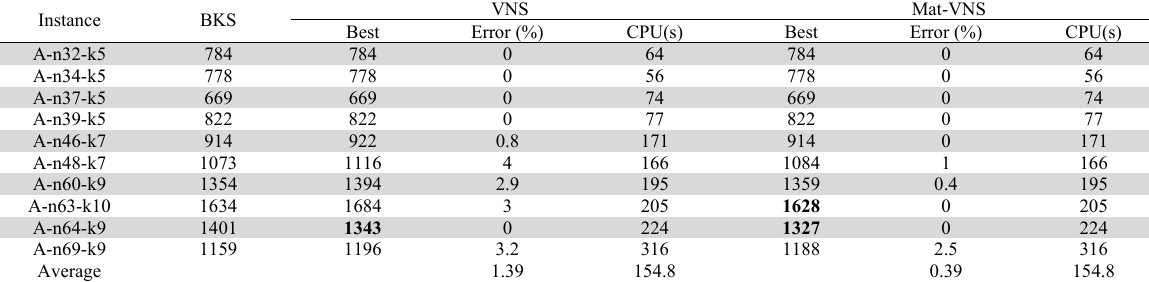
Fig. 8. Pseudo-code of the proposed Mat-VNS algorithm Table 4 The obtained results from VNS and Mat-VNS algorithms for CVRP test